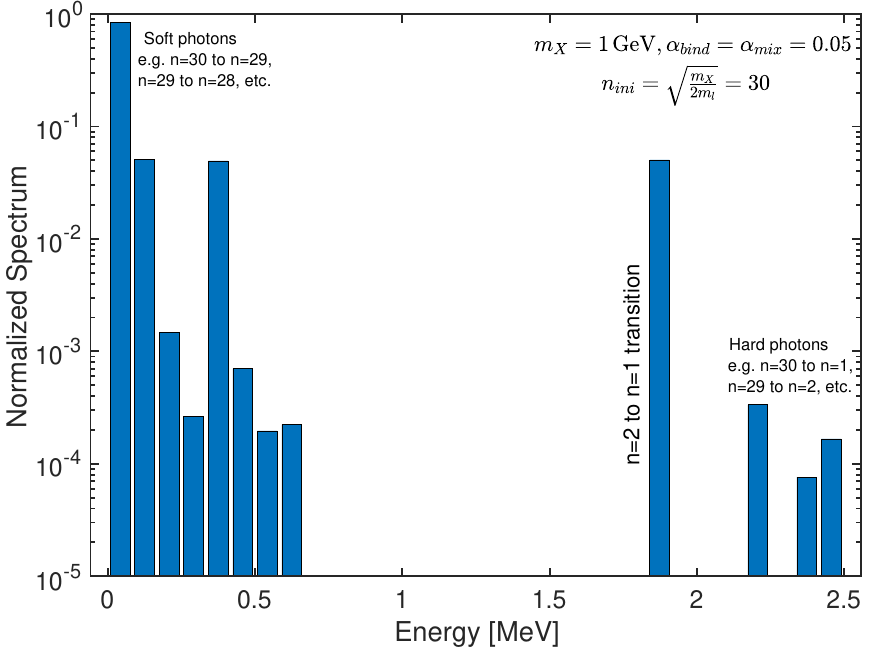
Figure 1. Example of a spectrum of emitted photons from the de-excitation of X ¯ X , produced at an energy level of n ini = 30 . Note that this does not include potential photons which could be generated from annihilation of both the X ¯ X and l ¯ l